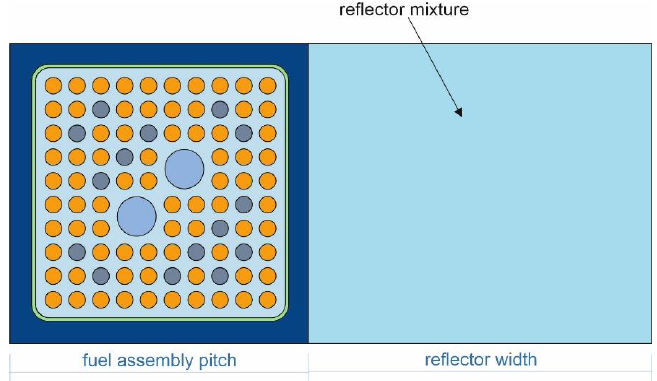
Figure 4. Reflector model for the cross-section preparation.